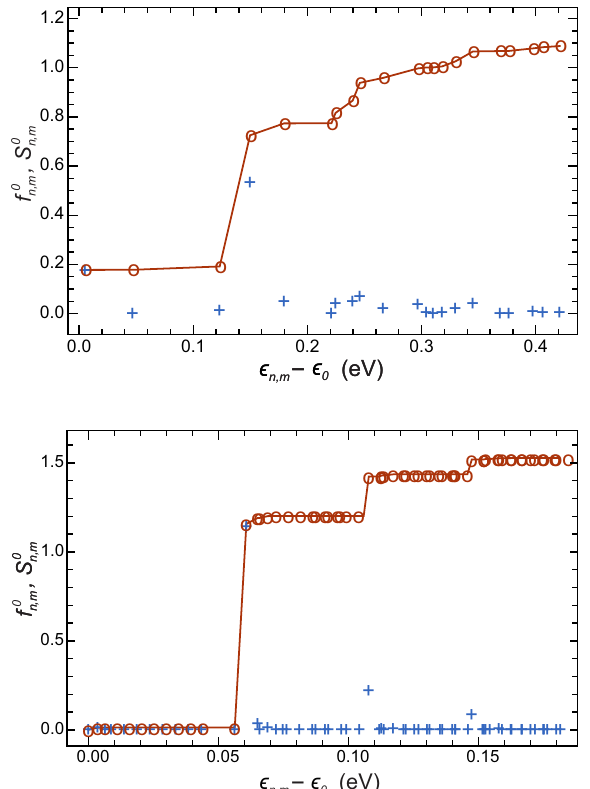
Figure 11. Blue crosses: Oscillator strengths f 0 n , m ; brown circles and full line: Cumulative sums S 0 n , m of these oscillator strengths; both for radiative transitions from the ground-state to states with n and m as quantum numbers and versus the excitation energy, (cid:101) n , m − (cid:101) 0 . Top : model 1, with R = 4 nm, a = 30 nm; bottom : model 2, with R = 40 nm, a = 200 nm. Notice that just a few oscillator strengths are dominant in the low-energy range considered in the graphs. Compare with the values of the sum rule given in Table